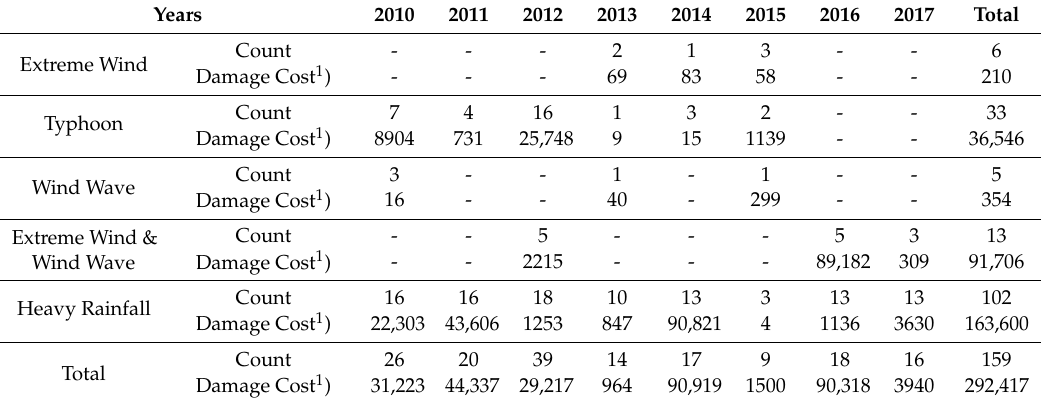
Table 2. Occurrence count and damage cost of natural disasters by